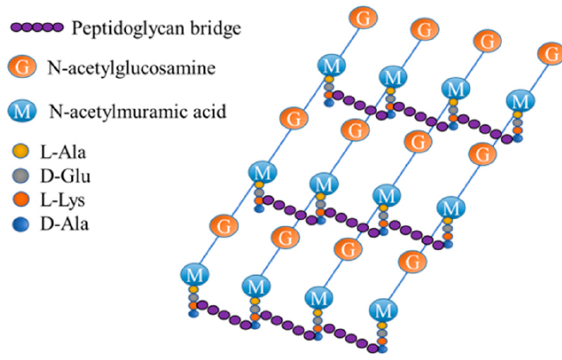
Figure 7. Structure of peptidoglycan from S. aureus .